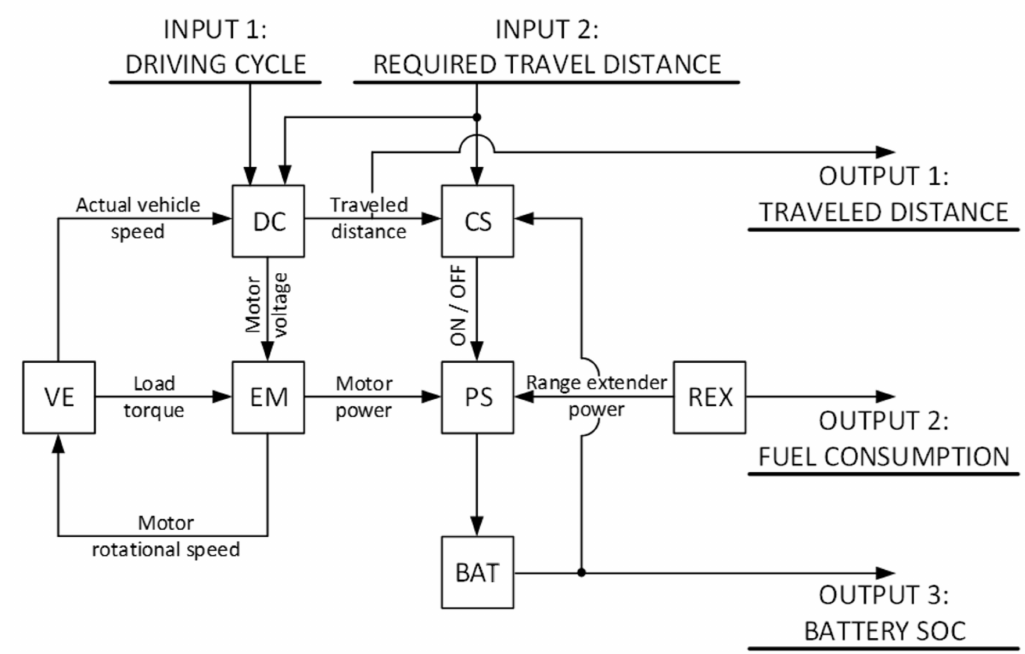
Figure 2. Simulation model topology. The diagram includes: VE—vehicle and driveline, EM—Electric Motor, DC—Driving Cycle, PS—power summing node, CS—Control Strategy, BAT—battery, and REX—Range